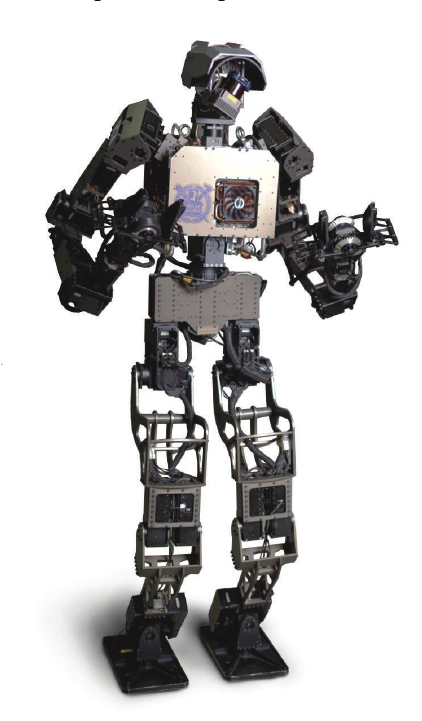
Figure 1. Humanoid robot